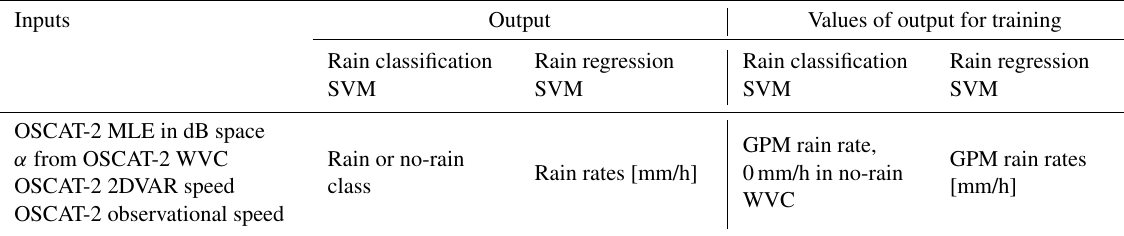
Table 3. Inputs and outputs for the SVM of rain classification and